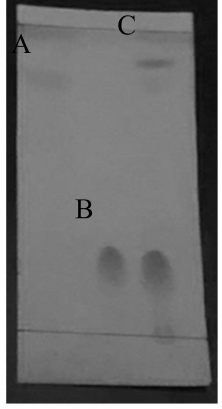
Figure 3. Thin layer chromatography result ( A ): methyl linoleate, ( B ): pyrogallol, ( C ): product.